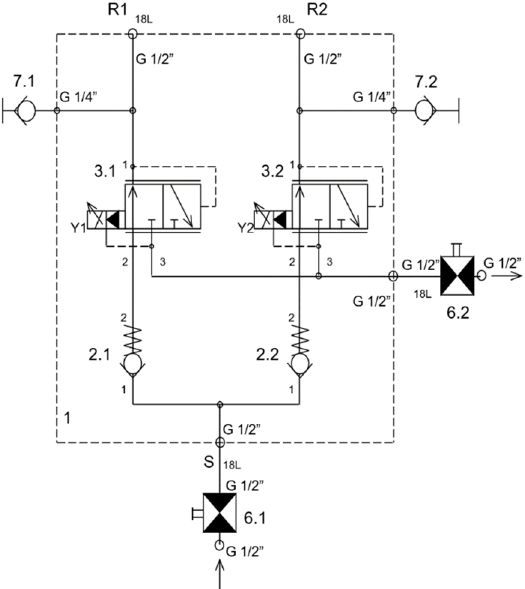
Figure 8. Hydraulic scheme of a modernized hydraulic circuit of the loading equipment where, port 1 is the main oil flow from the pump, port 2 is the main oil flow to the valve, and port 3 is the oil outflow from the valve